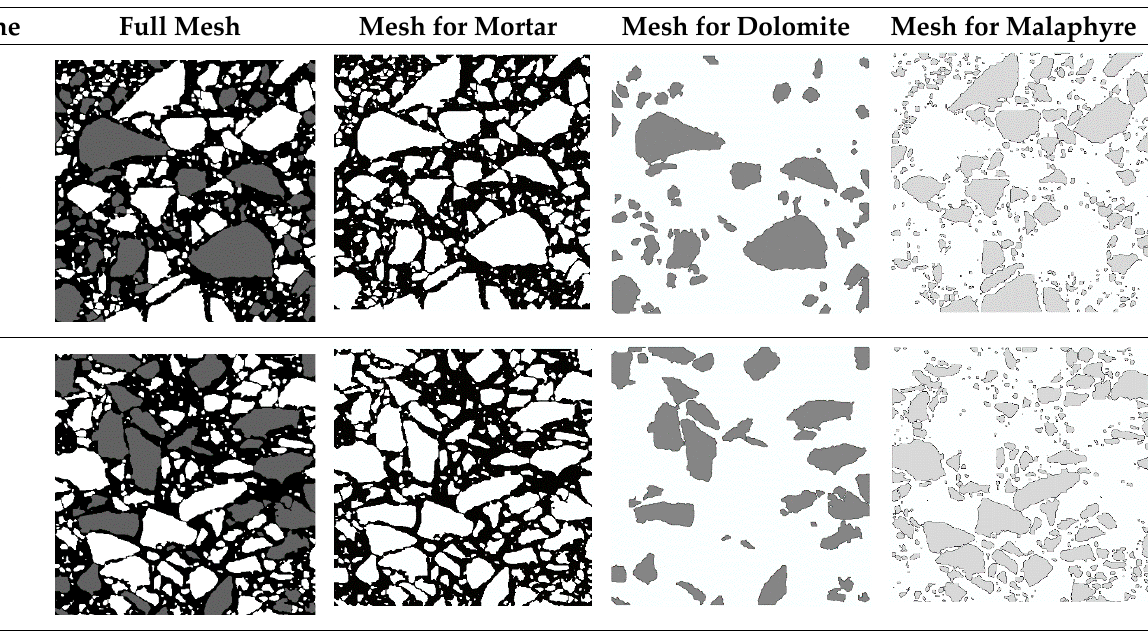
Figure 9. FEM mesh generated based on the source image for all asphalt mixture